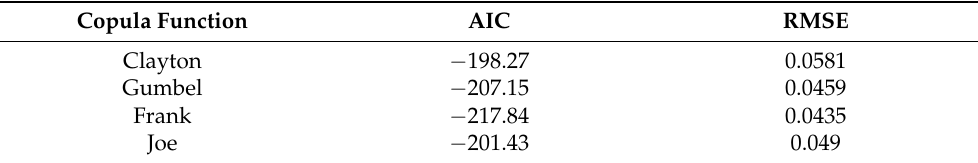
Table 2. Goodness-of-fit test results for the copula functions.